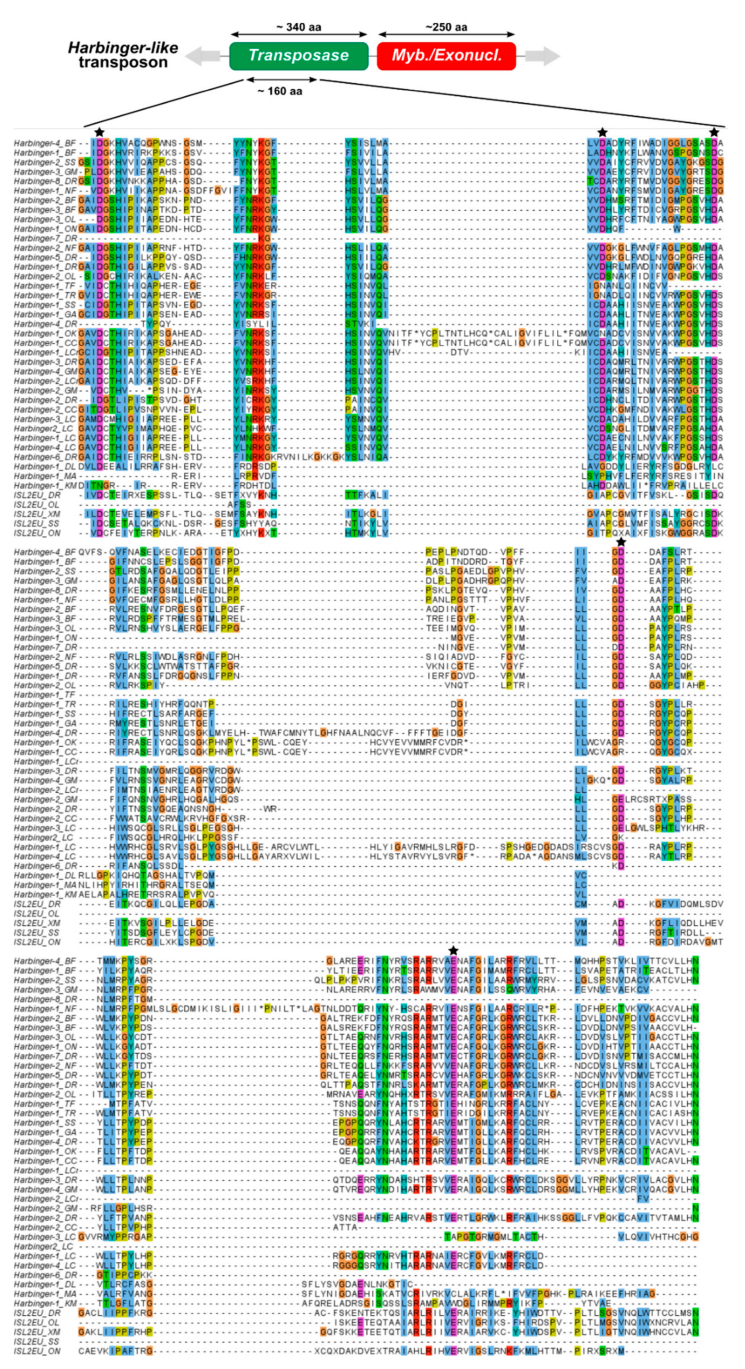
Figure 2. Multiple alignments of the Harbinger -like transposase proteins on the DDE domain. Con- served similar amino-acid residues are shown by a same color; black pentagrams indicate the putative catalytic DDE residues. BF: Branchiostoma floridae amphioxus, CC: Cyprinus carpio carp, DL: Dicentrar- chus labrax bass, DR: Danio rerio zebrafish, GA: Gasterosteus aculeatus stickleback, GM: Gadus morhua cod, KM: Kryptolebias marmoratus killifish, LC: Latimeria chalumnae coelacanth, LCr: Larimichthys crocea croaker, MA: Monopterus albus eel, NF: Nothobranchius furzeri killifish, OK: Oncorhynchus kisutch silver salmon, OL: Oryzias latipes medaka, ON: Oreochromis niloticus tilapia, SS: Salmo salar salmon, TF: Takifugu flavidus fugu, TR: Takifugu rubripes fugu, XM: Xiphophorus maculatus